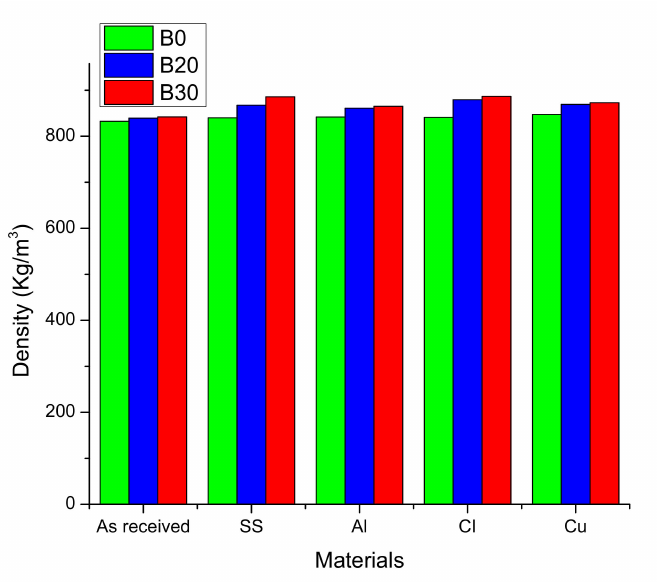
Figure 8. Change in the density of biodiesel after the immersion test with different